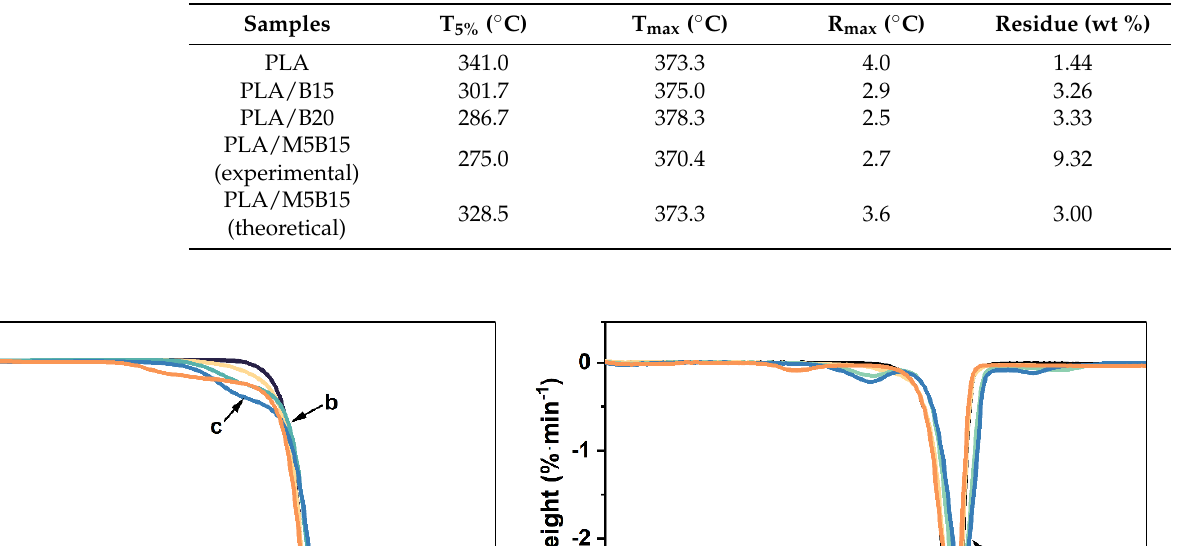
Table 5. Related thermal degradation parameters of PLA and PLA composites.